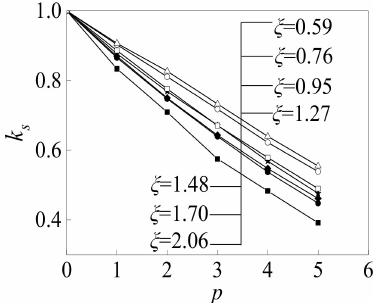
Figure 15. Influence of the constraint e ff ect constraint e ff ect coe ffi cient ζ and combination times p on K s of the